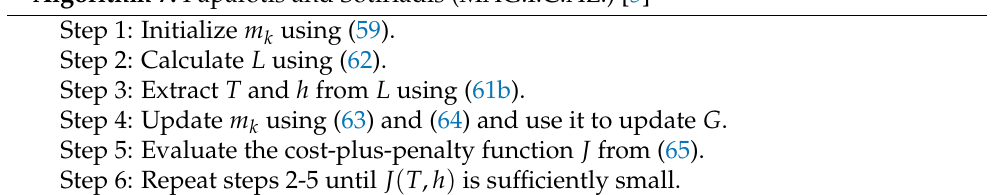
Algorithm 7: Papafotis and Sotiriadis (MAG.I.C.AL.)